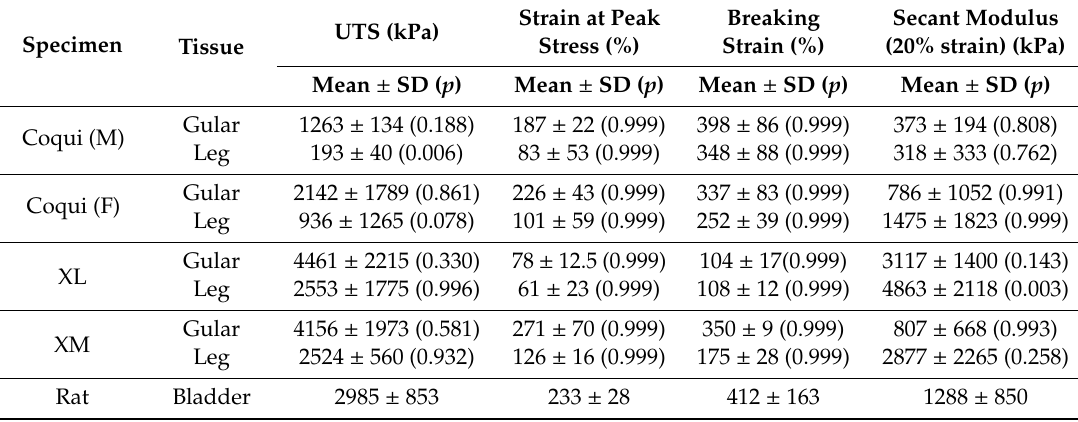
Table 1. Summary of the mechanical